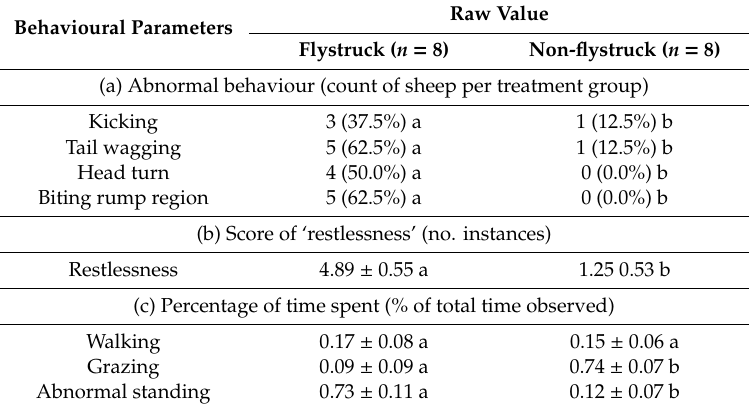
Table 3. Comparison of behavioural scoring for sheep in flystruck and non-flystruck treatment groups taken from video clips of 20 s